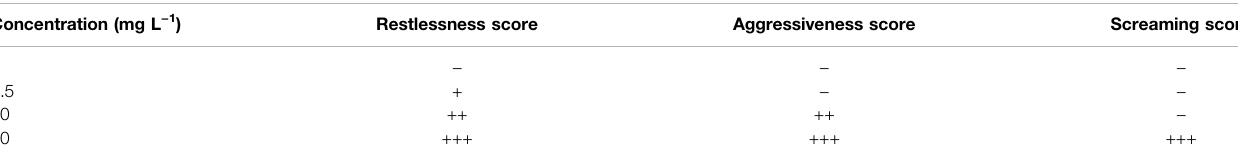
TABLE 2 | Different ethological alterations of male rats exposed to various concentrations of silica nanoparticles (SiNPs) for 96